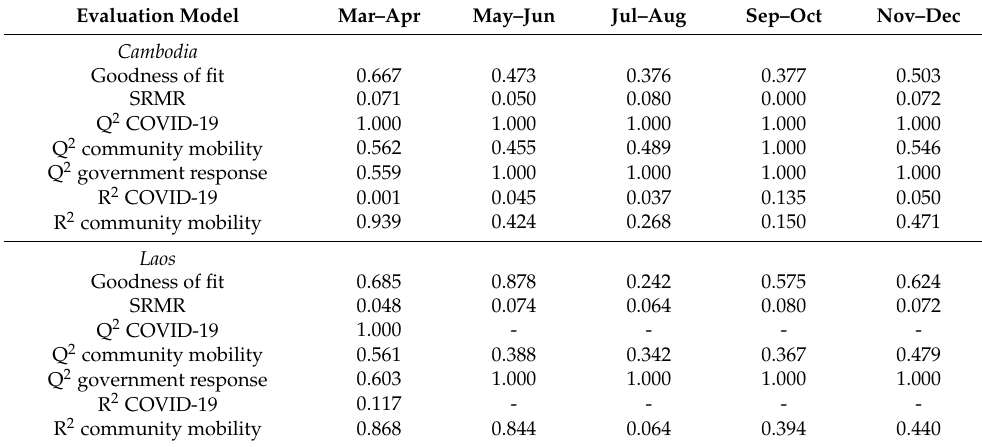
Figure 2. COVID-19 daily new cases and COVID-19 daily new death cases in Southeast Asian countries. Table 1. Model fit and structural model evaluation.